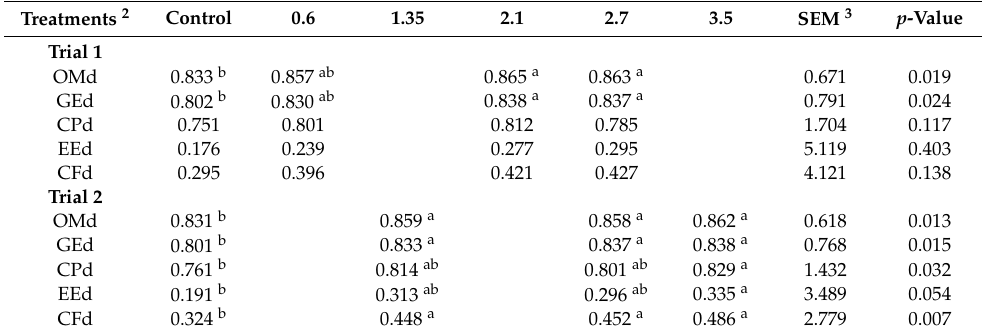
Table 3. E ff ect of the dilution ratio on the coe ffi cients of apparent total tract digestibility 1